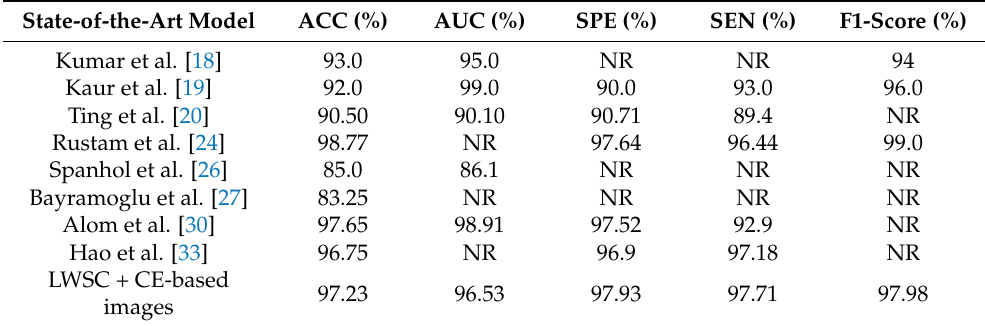
Table 4. A comparison analysis of the proposed model with state-of-the-art models on BreakHis dataset.